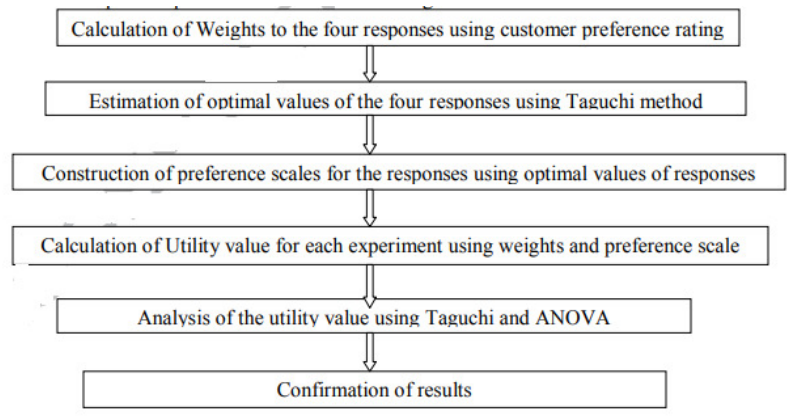
Figure 1. Flow chart illustrating the methodology